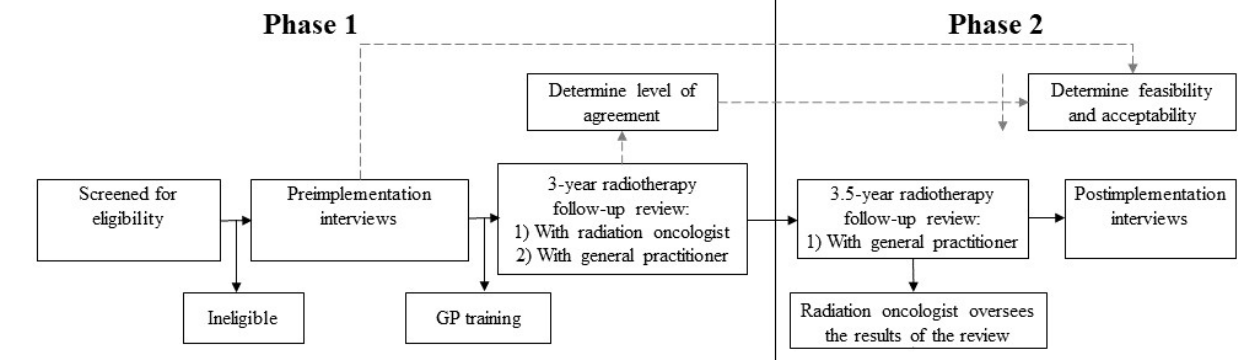
Figure 1. Flow diagram of study phases. GP: general